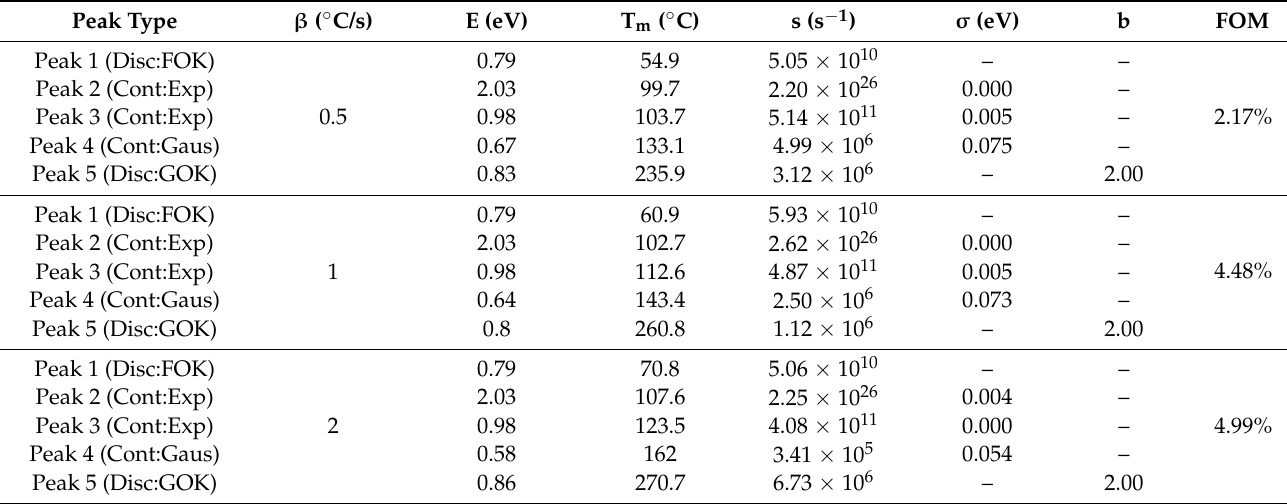
Table 5. Fitting results and traps parameters obtained for PPG glass samples irradiated with radiation dose of ca. 10 kGy and heating rates ( β ) of 0.5, 1.0, and 2.0 ◦